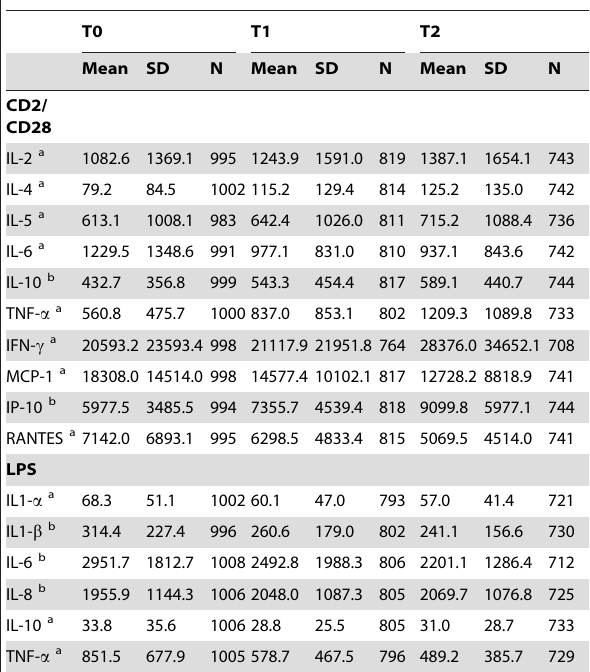
a log10-transformation applied; b square root-transformation applied. doi:10.1371/journal.pone.0029142.t001 PLoS ONE |